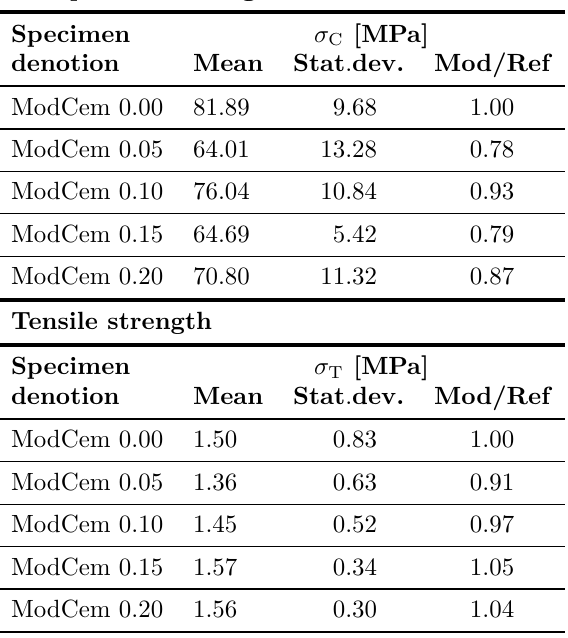
Table 2. Macromechanical test results.